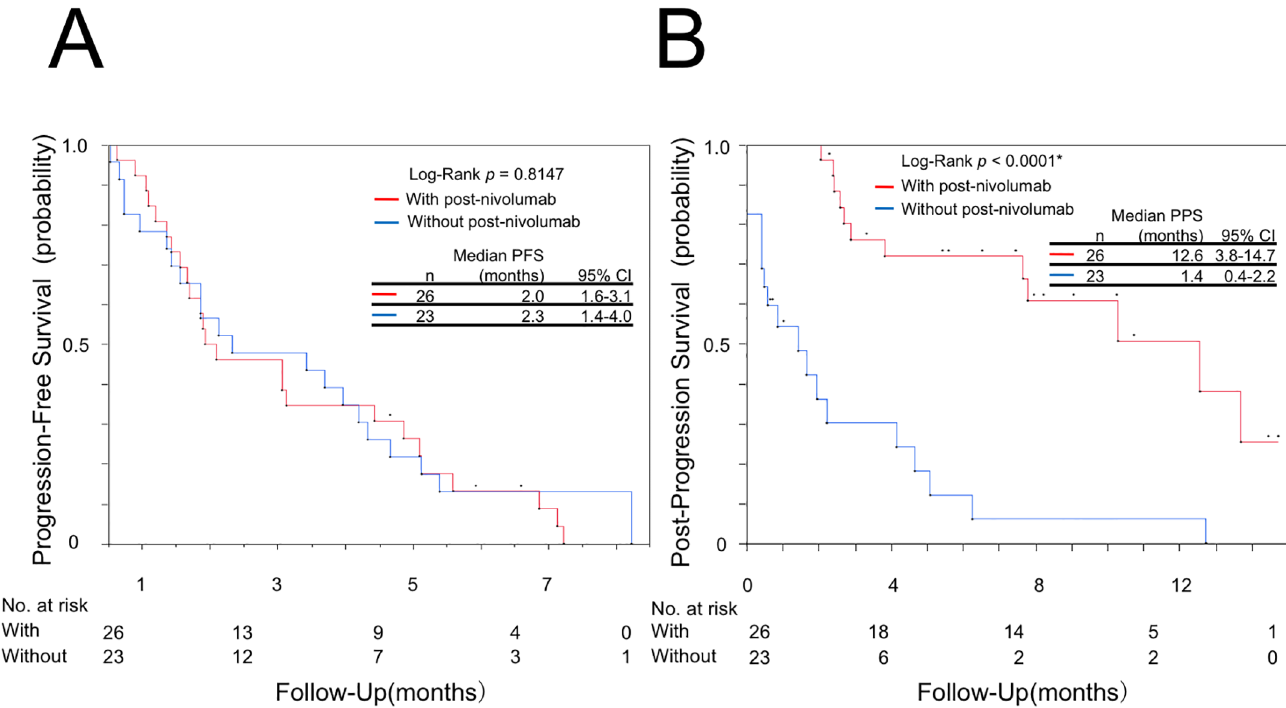
Fig 4. Kaplan-Meier plot. (A) progression-free survival (PFS) of first-line post-nivolumab treatment and (B) post-progression survival (PPS) after cessation of treatment with nivolumab in 26 patients who received post-nivolumab chemotherapy (red line), and 23 patients who did not receive post-nivolumab chemotherapy (blue line). CI; confidence